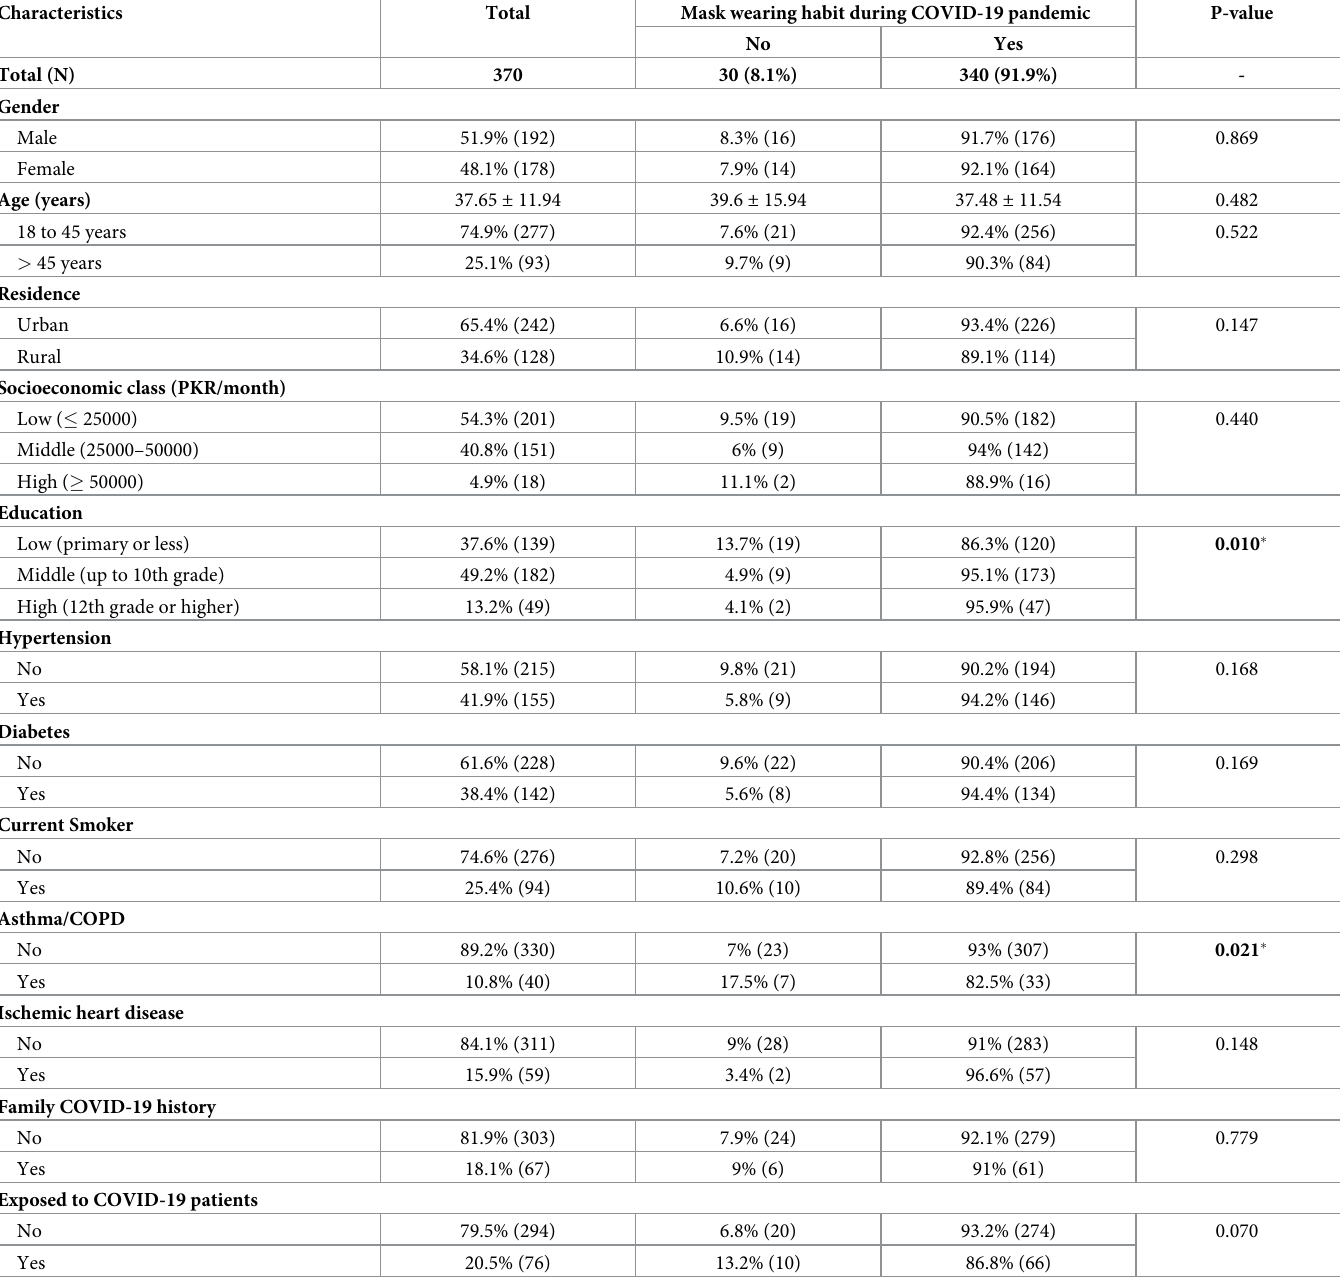
Table 1. Demographic characteristics and risk profile stratified by the face mask wearing habit of the respondent.